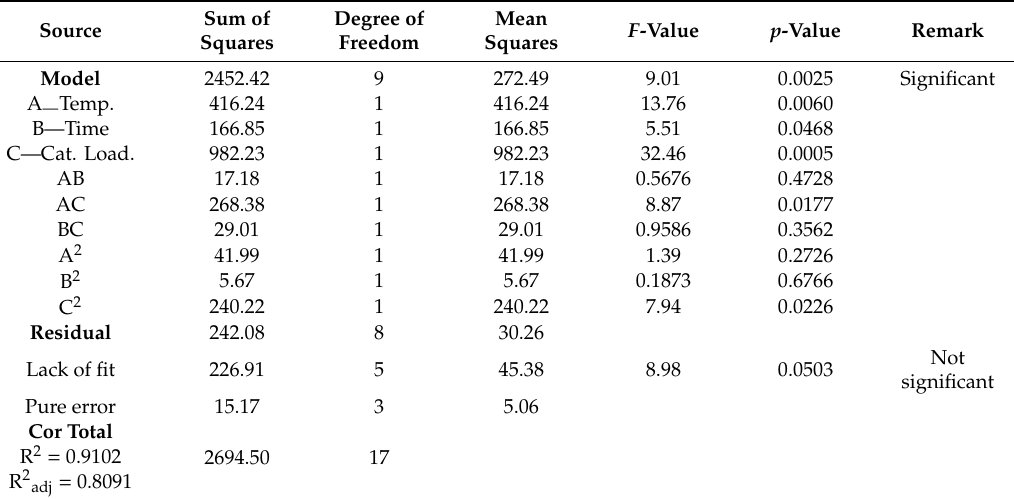
Table 5. ANOVA for the response surface quadratic